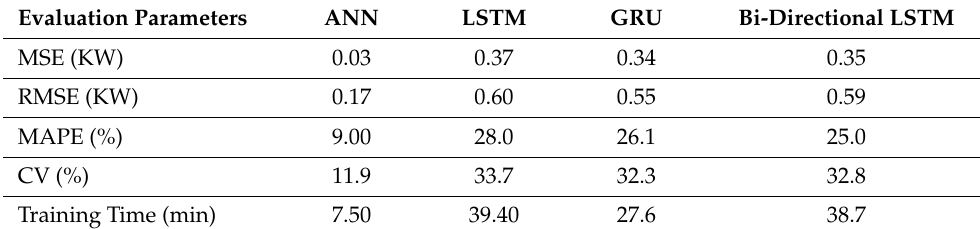
Table 3. Simulation results for hour-ahead load forecasting of a